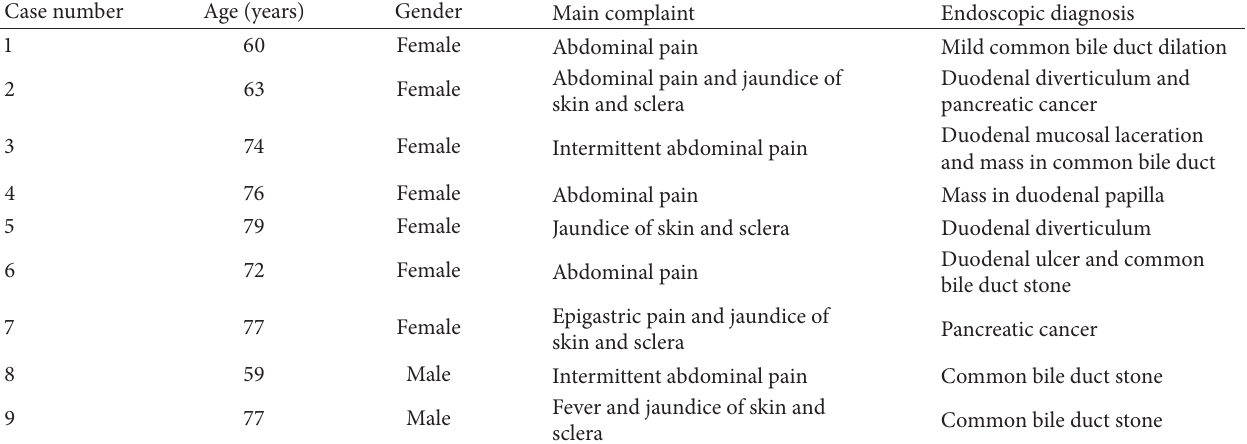
Table 1: Demographic and clinical characteristics of the patients ( 𝑛 = 9 ) with duodenal perforation.